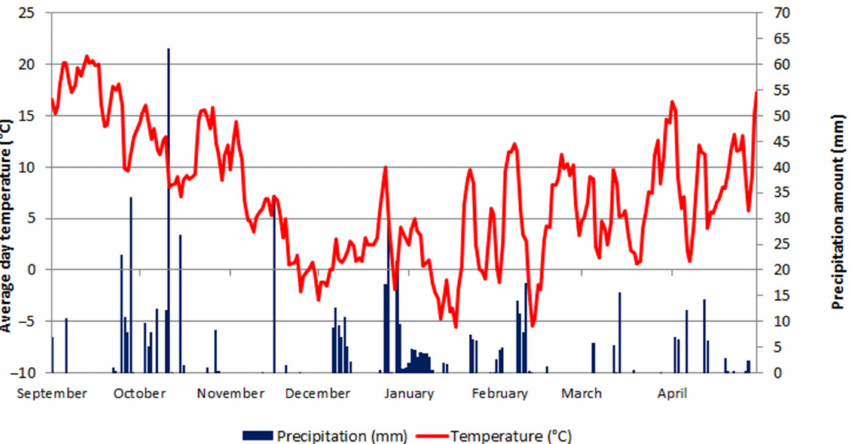
Figure 2. Day precipitation quantity and average temperatures in the time of composting